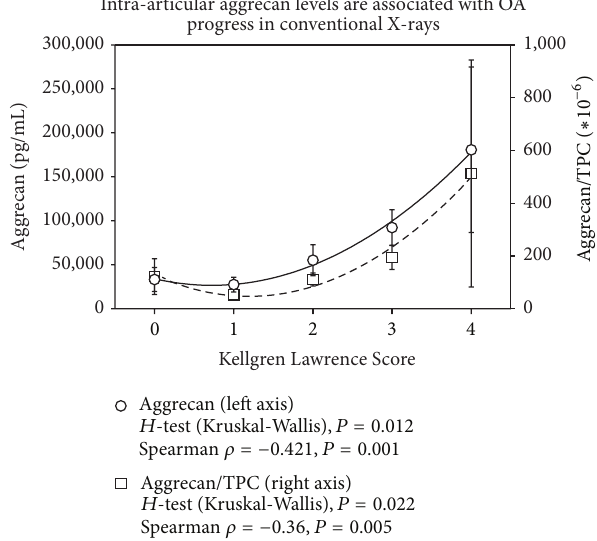
Figure 1: Increasing intra-articular levels of aggrecan are observed with progress of OA measured by radiological changes of the ankle (Kellgren Lawrence Score). Results of the polynomial regression analysis, the Spearman correlation, and the post hoc statistics (Krus- kal-Wallis H -Test) are indicated for absolute aggrecan levels and concentrations in relation to the total protein content (TPC) on the bottom. Polynomial regression with degree of 2 gives an 𝑅 2 = 0.9941 for absolute and 𝑅 2 = 0.9811 for relative concentrations; values are shown with ± SEM.